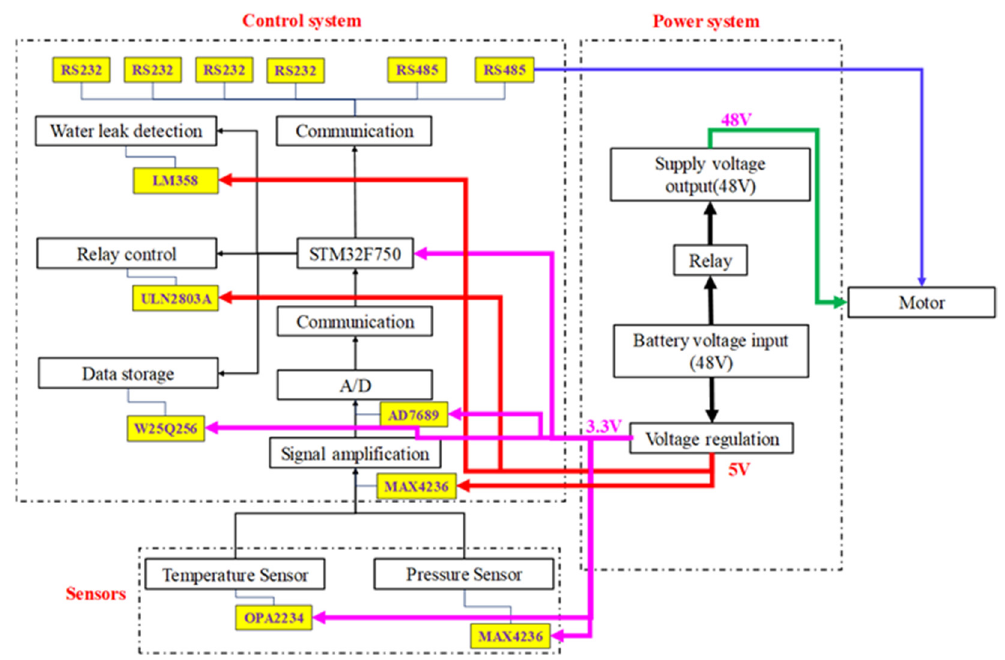
Figure 3. Control system of PMTI.